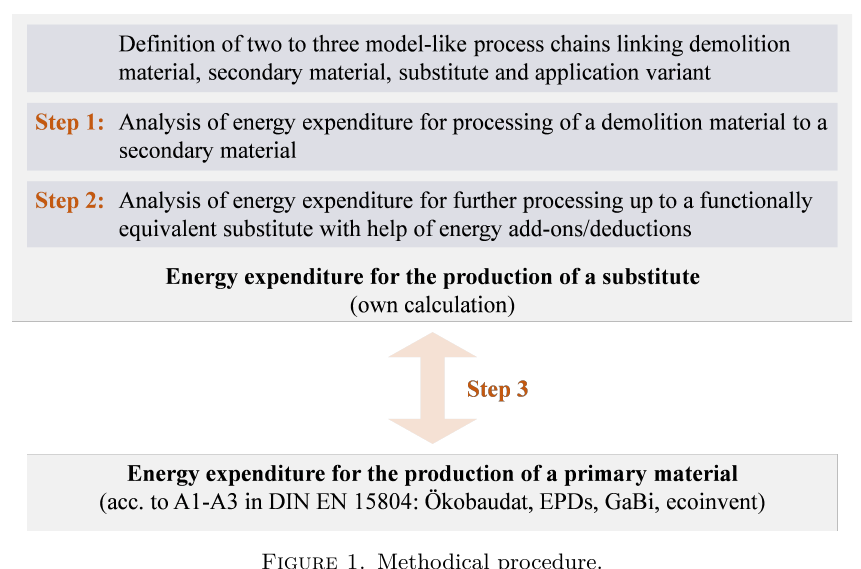
Figure 1. Methodical